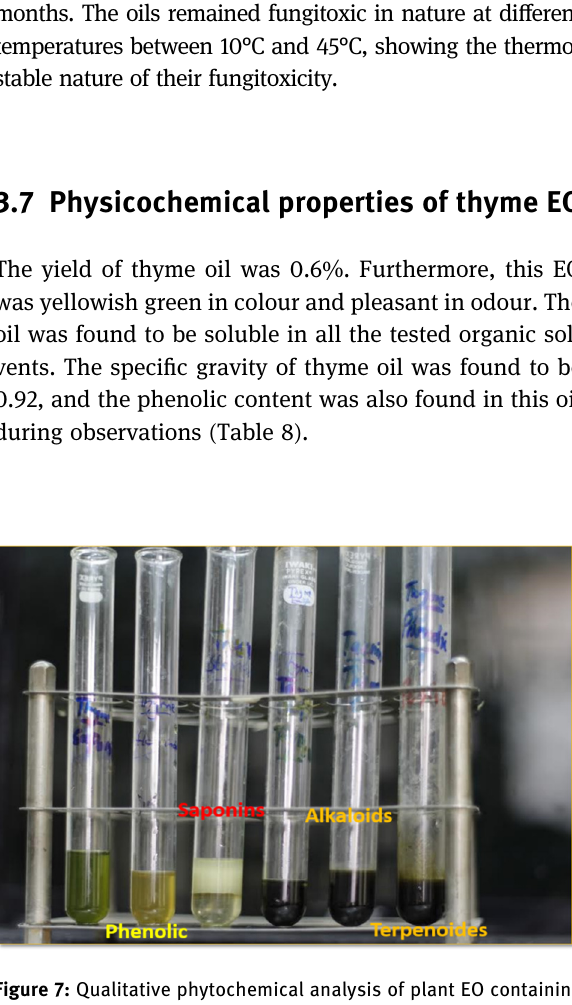
Figure 7: Qualitative phytochemical analysis of plant EO containing anti - fungal